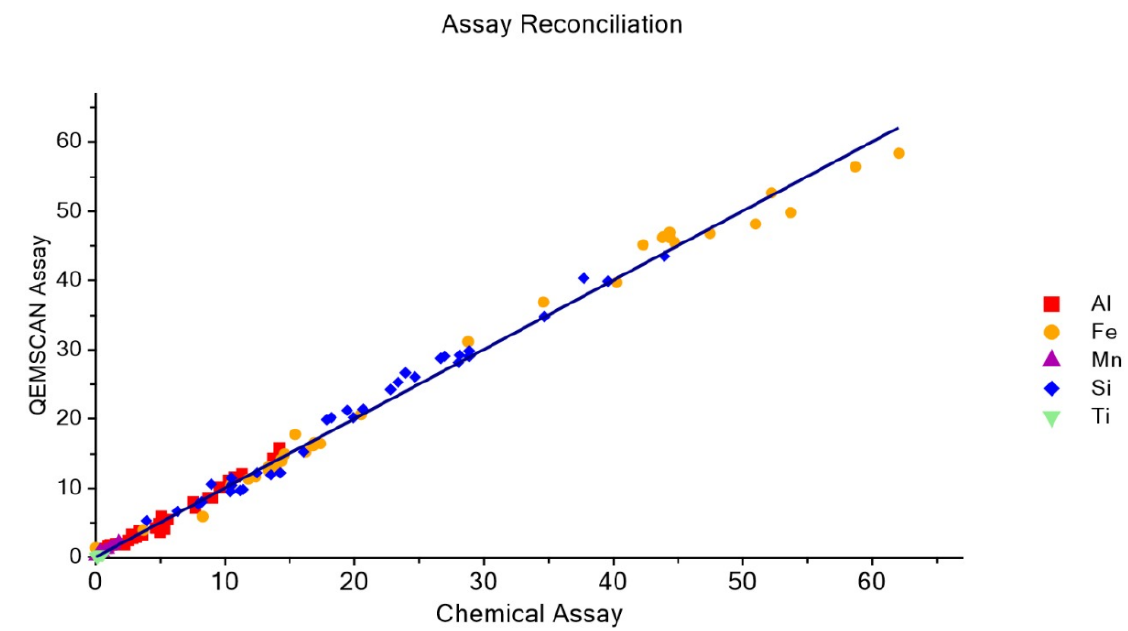
Figure 2. Assay reconciliation of QEMSCAN measurements.